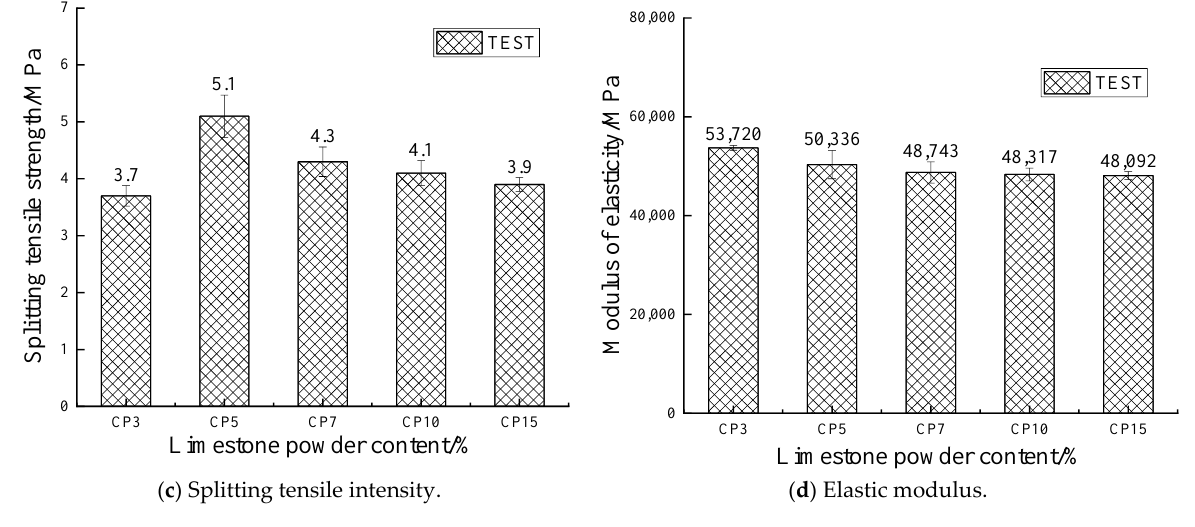
( d ) Elastic modulus. Figure 4. Mechanical characteristics of concrete with different LP contents. Figure 4. Mechanical characteristics of concrete with different LP contents.